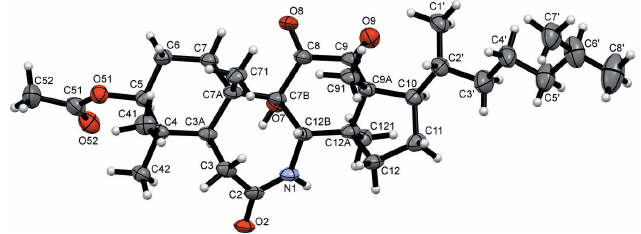
Figure 2 ORTEP view of the title compound showing the labelling scheme and displacement ellipsoids drawn at the 50% probability level. The minor occupancy portion of the disordered methylheptane molecule is not shown for